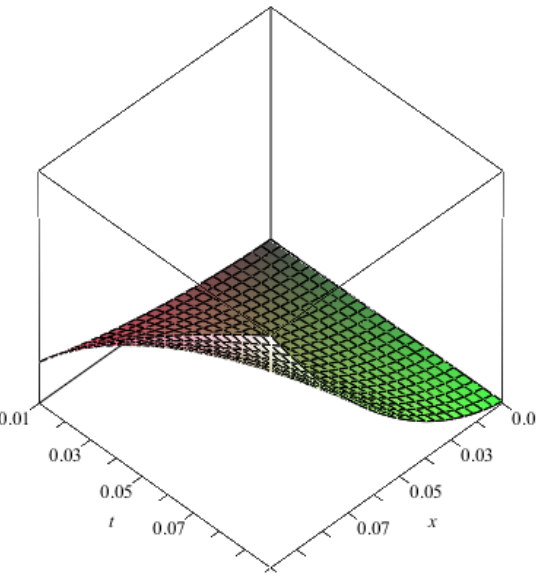
Fig. 12 Values of v 3 ( x , t ) for α = 0 .